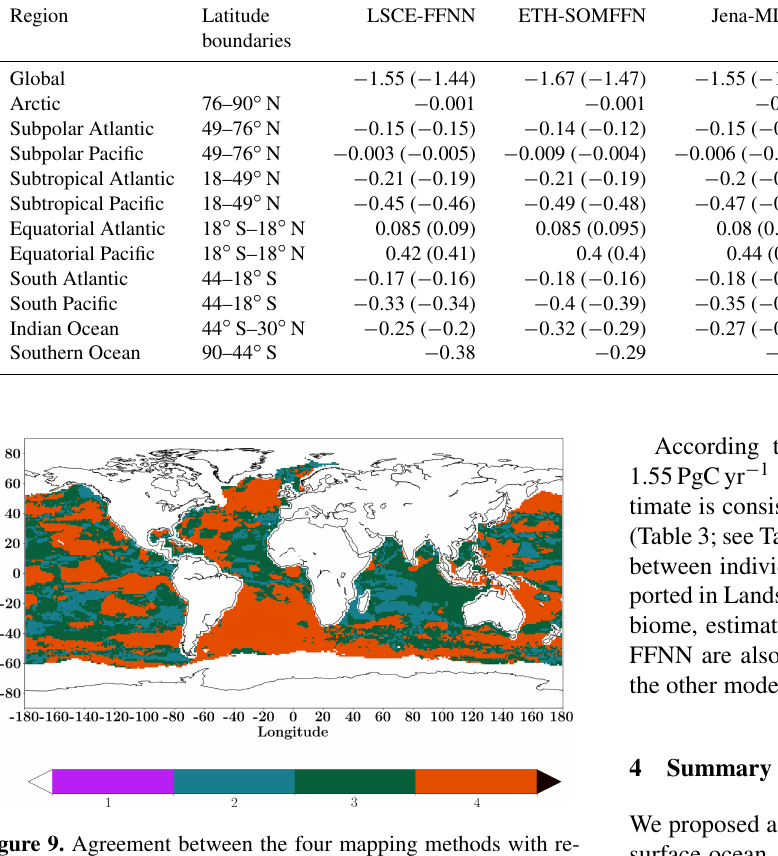
Figure 9. Agreement between the four mapping methods with re- spect to their linear trend of sea–air CO 2 flux. The color bar rep- resents the number of products that have the same sign of linear